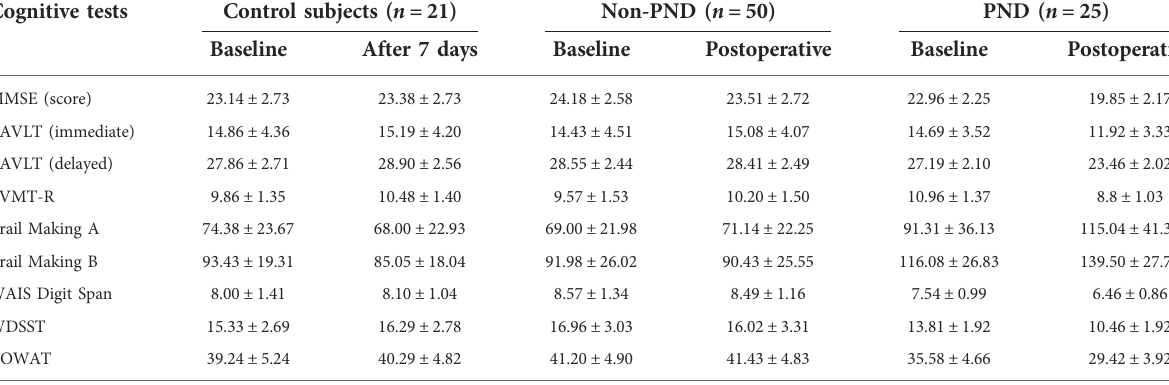
TABLE 2 Cognitive performance of patients and control